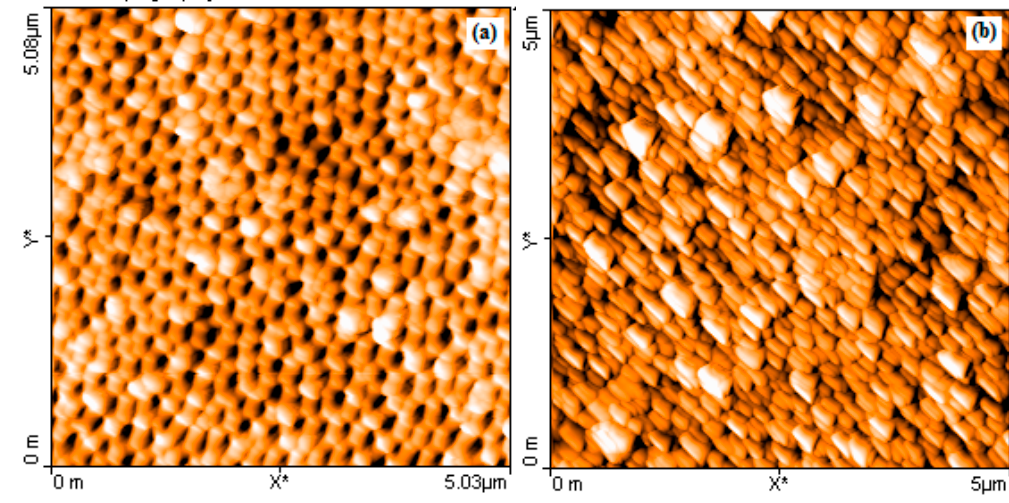
Figure 12. AFM micrographs of 80 nm pore size NAAO substrate before ( a ); and after depositing 70 nm thick gold film using the sputtering technique ( b ).